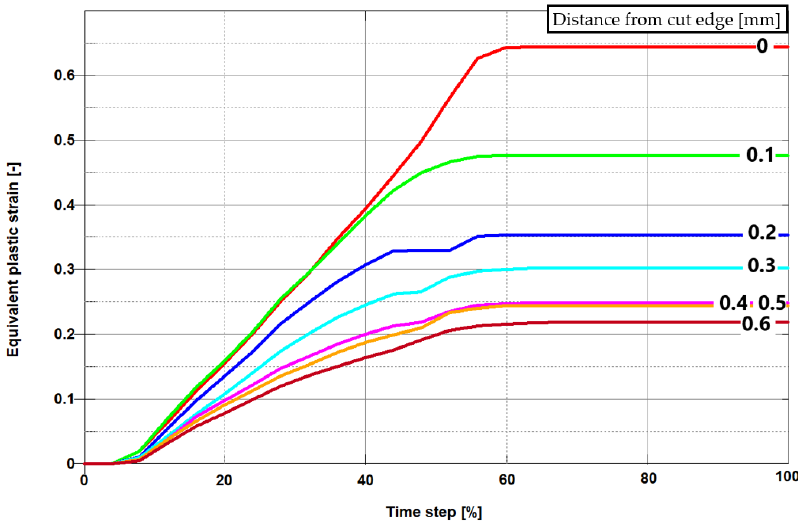
Figure 13. Equivalent plastic strain on sheared edge measured for h c = 0.06 mm (FEM model).